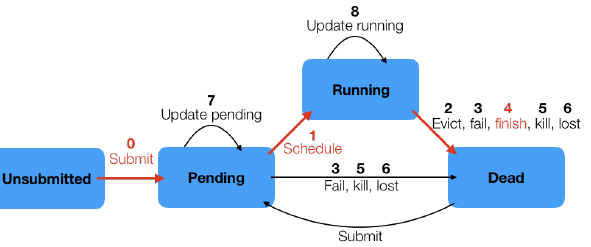
Figure 2. Trace state transitions, adapted from [24]. The red path is the optimal task life